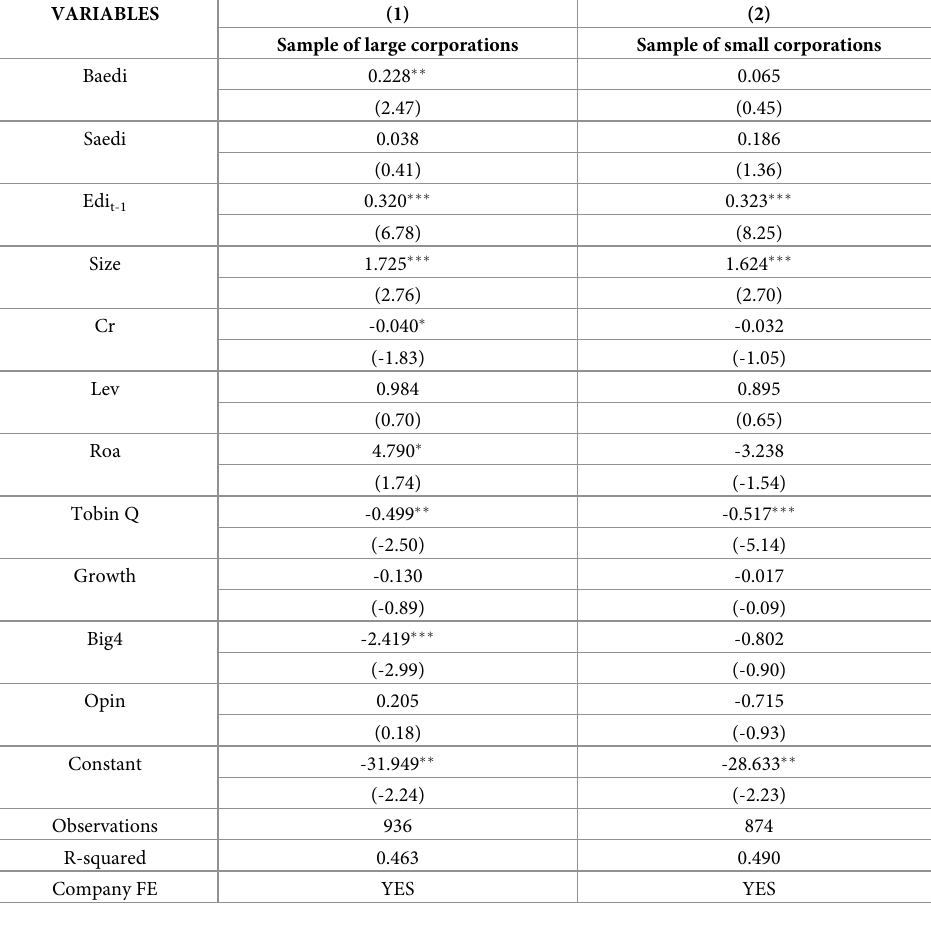
Table 8. Grouping regression results of corporation size